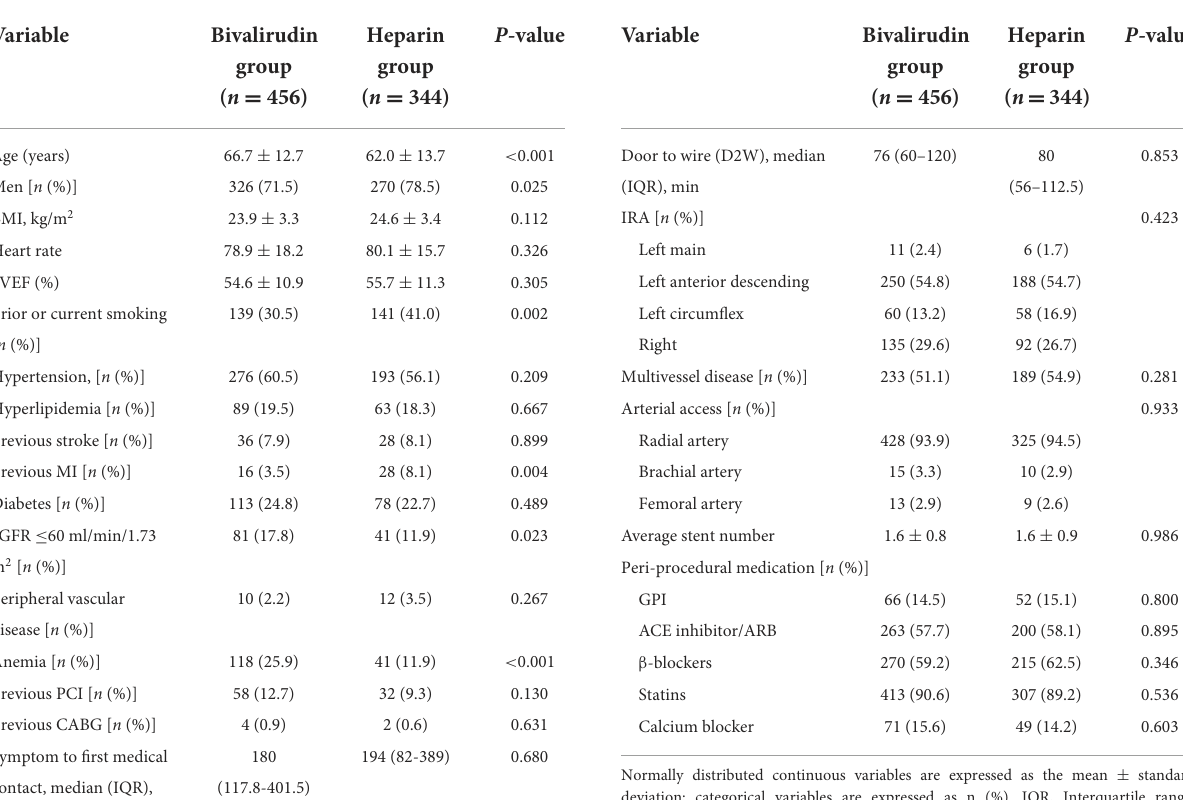
TABLE 1 Basic clinical characteristics. TABLE 2 Treatment and procedural